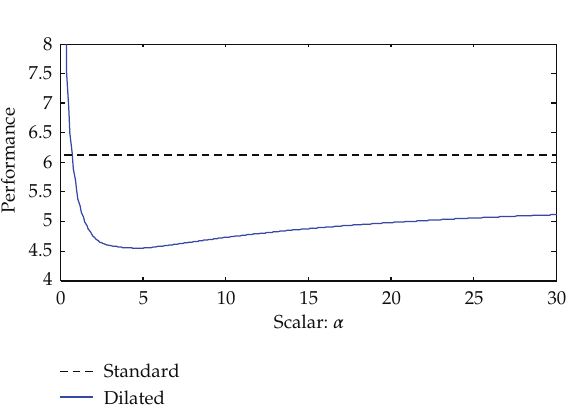
Figure 2: The relation between the performance level γ and the scalar α